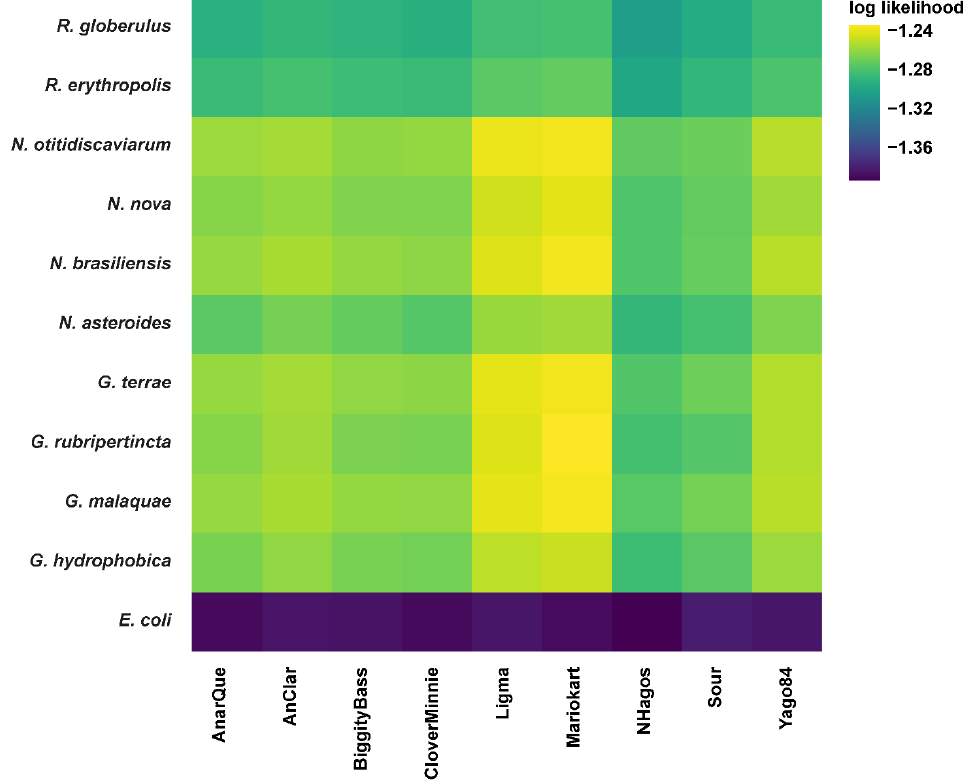
Figure 1. Putative host ranges as predicted by WIsH. Heatmap of log-likelihoods of bacteriophage- host pairs—including nine Gordonia cluster DR bacteriophages (Supplementary Table S1) as well as ten potential bacterial hosts and E. coli as a negative control (Supplementary Table S3)—generated by the host prediction tool WIsH [21]. Higher values correspond to more likely interactions. Supplementary Materials: The following supporting information can be downloaded at: www.mdpi.com/xxx/s1, Figure S1: Phamerator map of the RuvC-like resolvase gene; Figure S2: Pha- merator map of the hicA -like toxin gene; Figure S3: Neighbor-joining trees; Figure S4: Dot plots; Figure S5: Average nucleotide identities; Table S1: Gordonia cluster DR bacteriophages included in the comparative analyses; Table S2: Bacteriophages included as outgroups in the comparative anal- yses; Table S3: Host bacteria included in the comparative analyses. Author Contributions: Conceptualization and funding acquisition, S.P.P.; data curation, C.J.V. and A.A.H.; formal analysis and visualization, C.J.V., A.A.H., T.A., M.B., A.B., E.C., N.H., W.L., J.L., M.L., M.M., R.M., C.M., M.S. (Maria Strasser), S.M., Z.P., M.S. (Minerva So), M.S. (Makena Sy), and S.W.; C.J.V., A.A.H., and S.P.P. wrote this manuscript with input from all authors. All authors have read and agreed to the published version of the manuscript. Funding: This research was funded by a National Science Foundation CAREER grant to SPP, grant number DEB-2045343. Data Availability Statement: Genomic data for Gordonia cluster DR bacteriophages, bacteriophages included as outgroups, and putative bacterial host species can be downloaded from the NCBI Se- quence Read Archive using the accession numbers provided in Supplementary Tables S1, S2, and S3, respectively. Acknowledgments: We are grateful to Suhail Ghafoor for IT support.